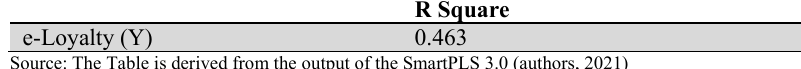
R Square Value R Square R Square Adjusted e-Loyalty (Y) 0.463